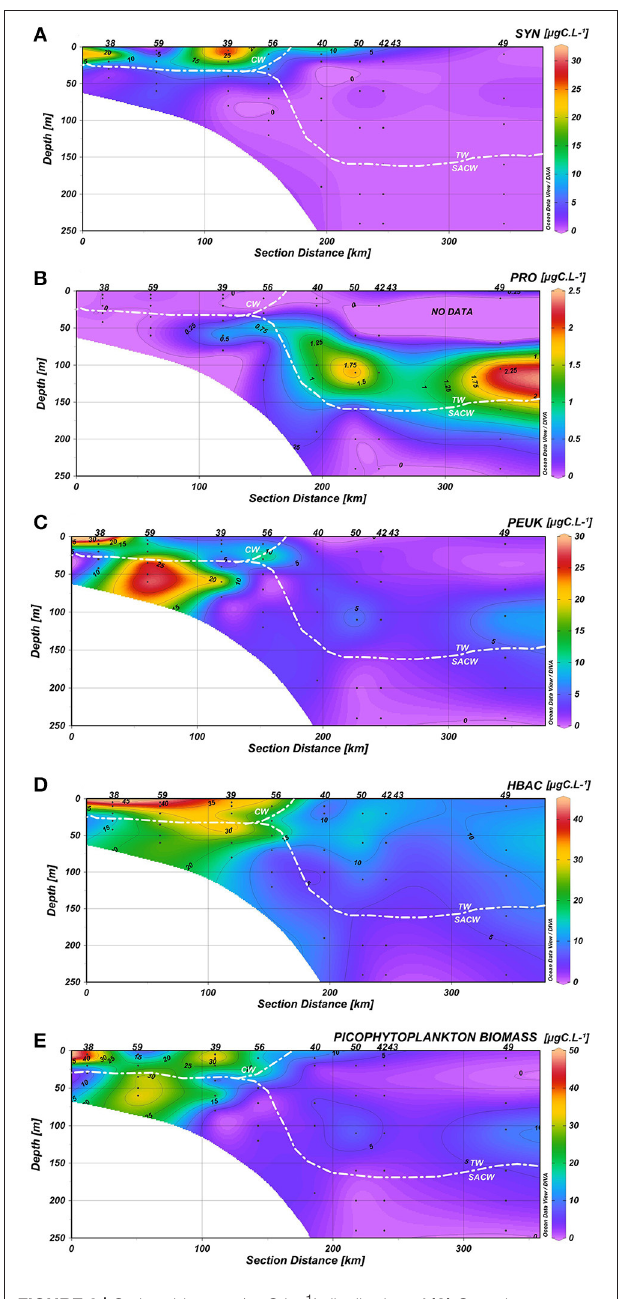
FIGURE 6 | Carbon biomass ( µ gC.L − 1 ) distribution of (A) Synechococcus (SYN), (B) Prochlorococcus (PRO), (C) Picoeukaryotes (PEUK), (D) Heterotrophic bacteria (HBAC), (E) Total picophytoplankton in the water column along the coastal-ocean gradient.